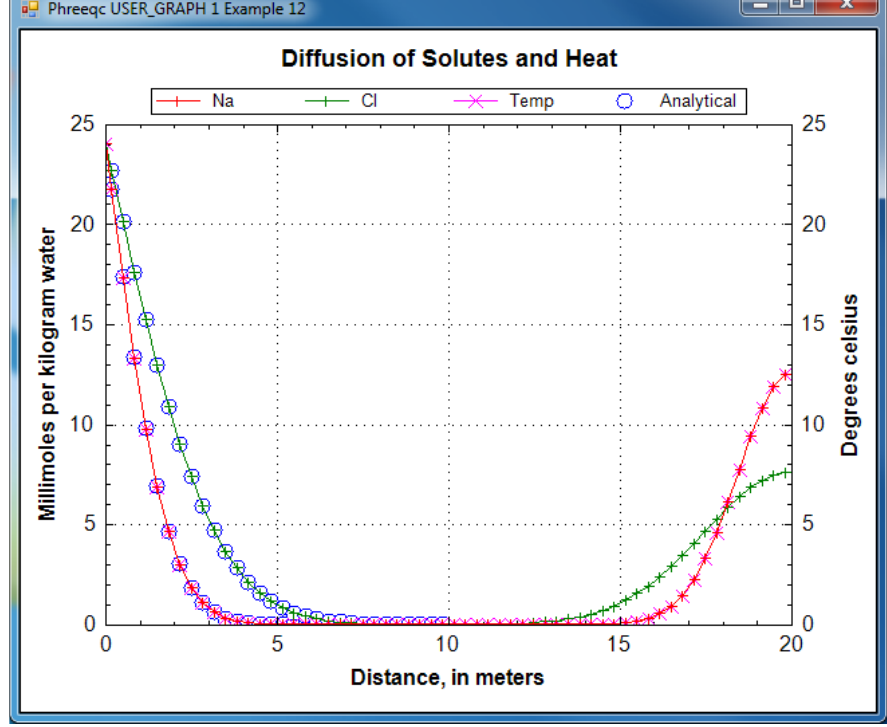
Figure 13. Simulation results for diffusion from column ends of heat and Na + (retardation R = 3) and Cl - ( R = 1) compared with constant-boundary-condition analytical solution.